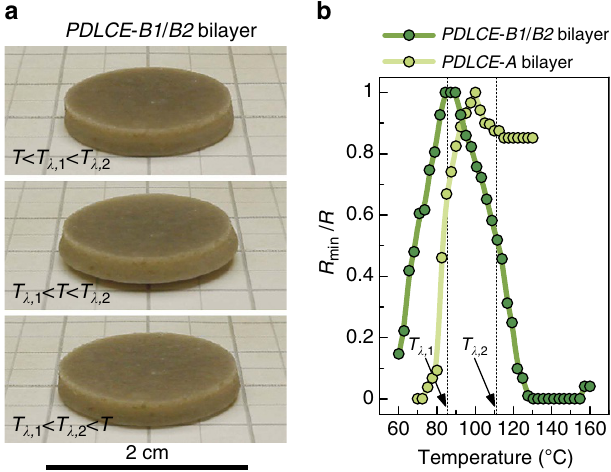
Figure 7 | Beat-like thermomechanical actuation. ( a ) Photographs of cup- shape morphing behaviour in a bilayer PDLCE sample PDLCE-B1/B2 in which the top layer is made of PDLCE-B1 and the bottom layer of PDLCE-B2 , both with n || Z . The difference in T l between the two layers leads to strong mismatching of local strains at the layer interface at temperatures intermediate between T l ,1 and T l ,2 , compensated by non-planar deformation of the specimen ( a , middle). For comparison, the n || Z monolayered PDLCE-A specimen of Fig. 4 remains planar in the whole temperature range. ( b ) Comparison of the step-like thermomechanical actuation of a bilayer PDLCE-A sample (for example, cup-shaped specimen of Fig. 5b) and of the beat-like thermomechanical actuation of bilayered PDLCE-B1/B2 , using the relative surface curvature R min / R as the measure of mechanical deformation.